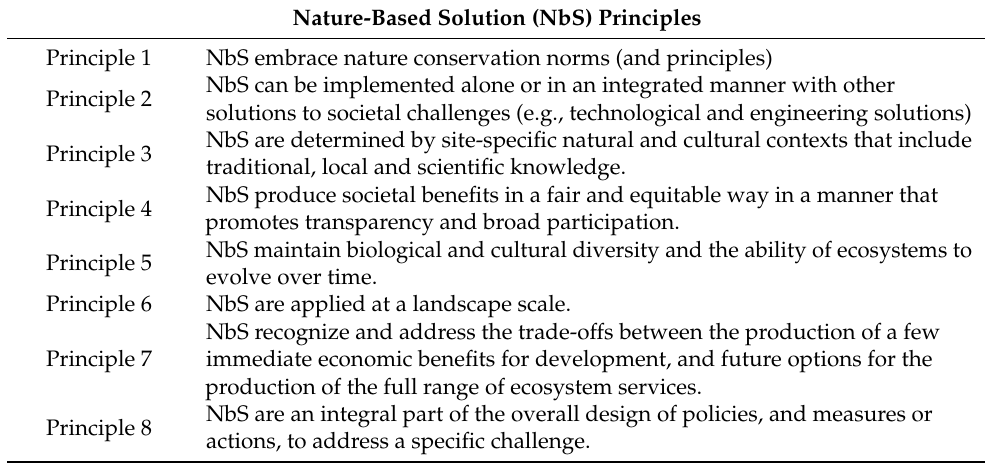
Table 2. Nature-based solution principles used in evaluation of Ecosystem-based adaptation strate-